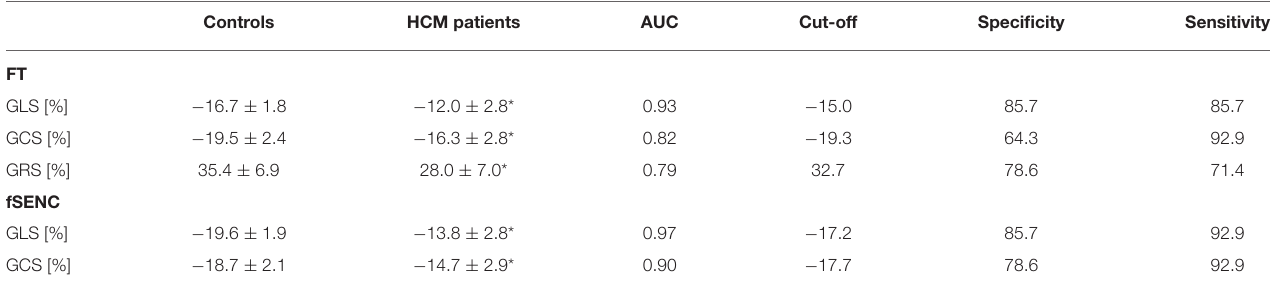
TABLE 4 | Global strain values, AUCs and cut-off-values for pathology